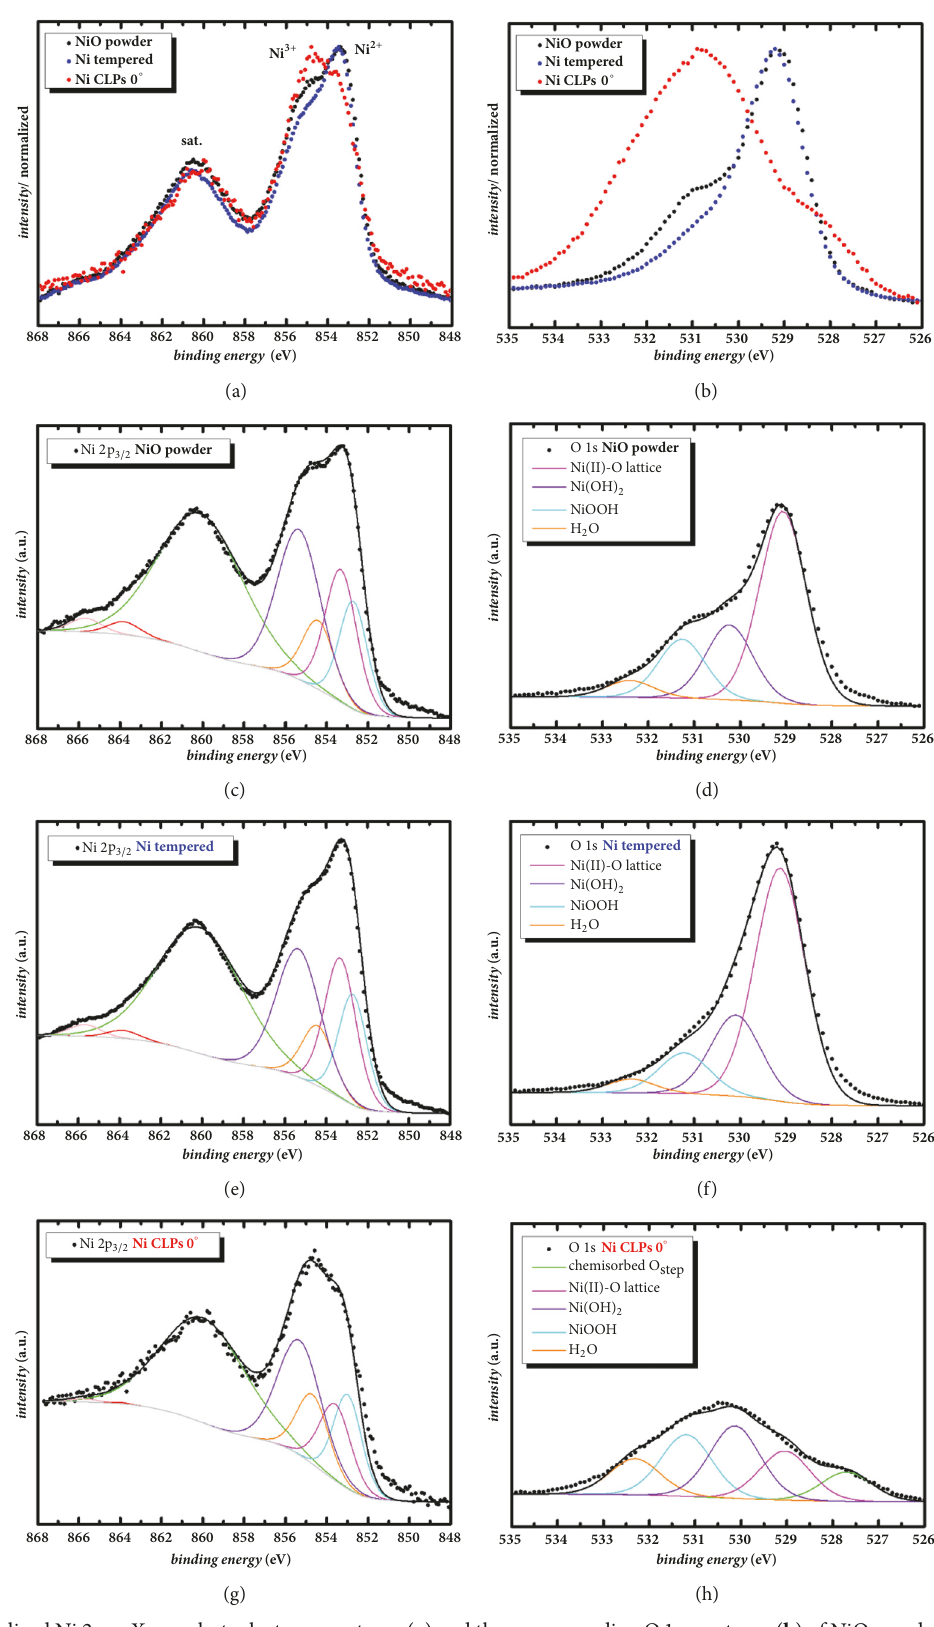
Figure 2: Normalized Ni 2p 3/2 X-ray photoelectron spectrum ( a ) and the corresponding O 1s spectrum ( b ) of NiO powder used as reference sample and the temperedas well as laser-structuredNi electrodes.Fitted X-rayphotoelectronspectraof NiO powder ( c-d ),Ni tempered( e-f ), and Ni CLPs 0 ∘ ( g-h ). Data were fitted according to Grosvenor et al.